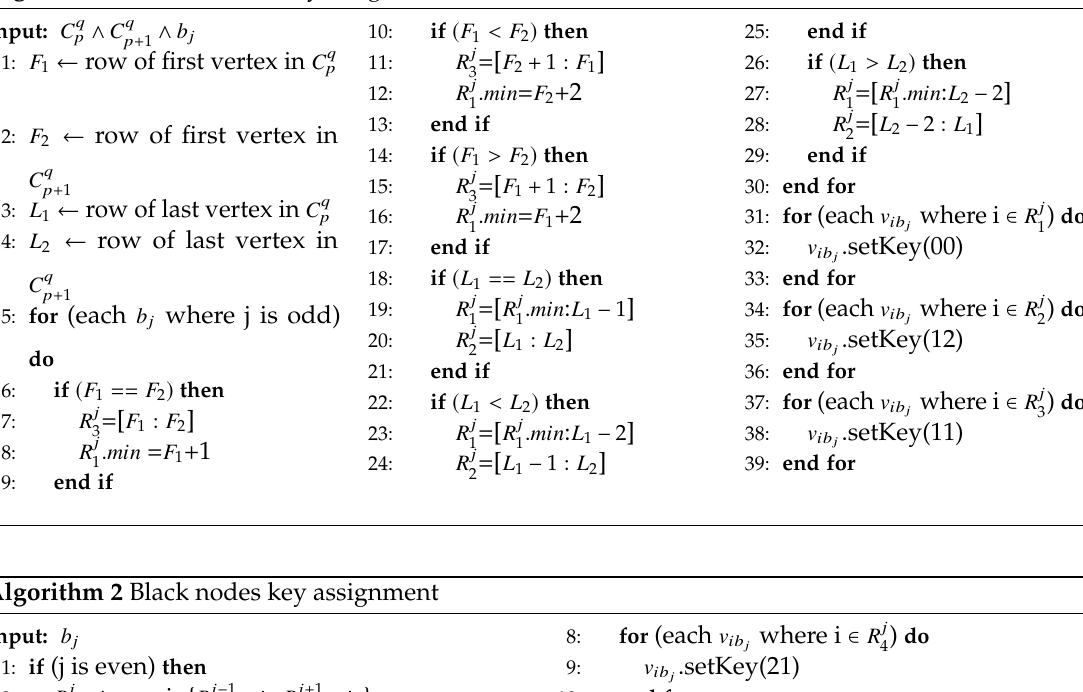
Algorithm 1 Brown nodes key assignment